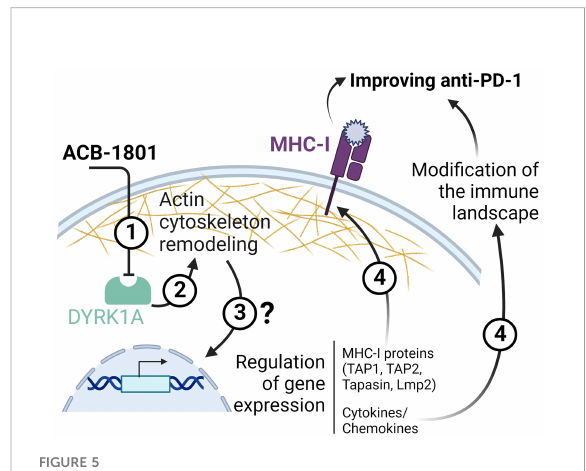
FIGURE 5 Schematic representation of the proposed role of ACB-1801. By inhibiting DYRK1A (1), ACB-1801 induces actin cytoskeleton remodeling (2) and phenotypic switch of cancer cells. Such phenotypic switch can regulate the expression of several genes (3) of the MHC-I and various cytokines and chemokines by mechanism(s) which are not fully understood. The regulation of several genes of MHC-I (TAP1, TAP2, Tapasin and Lmp2) leads to an overexpression of MHC-I (4). Whereas, the regulation of cytokine/chemokines genes induces a modi fi cation of the tumor immune landscape